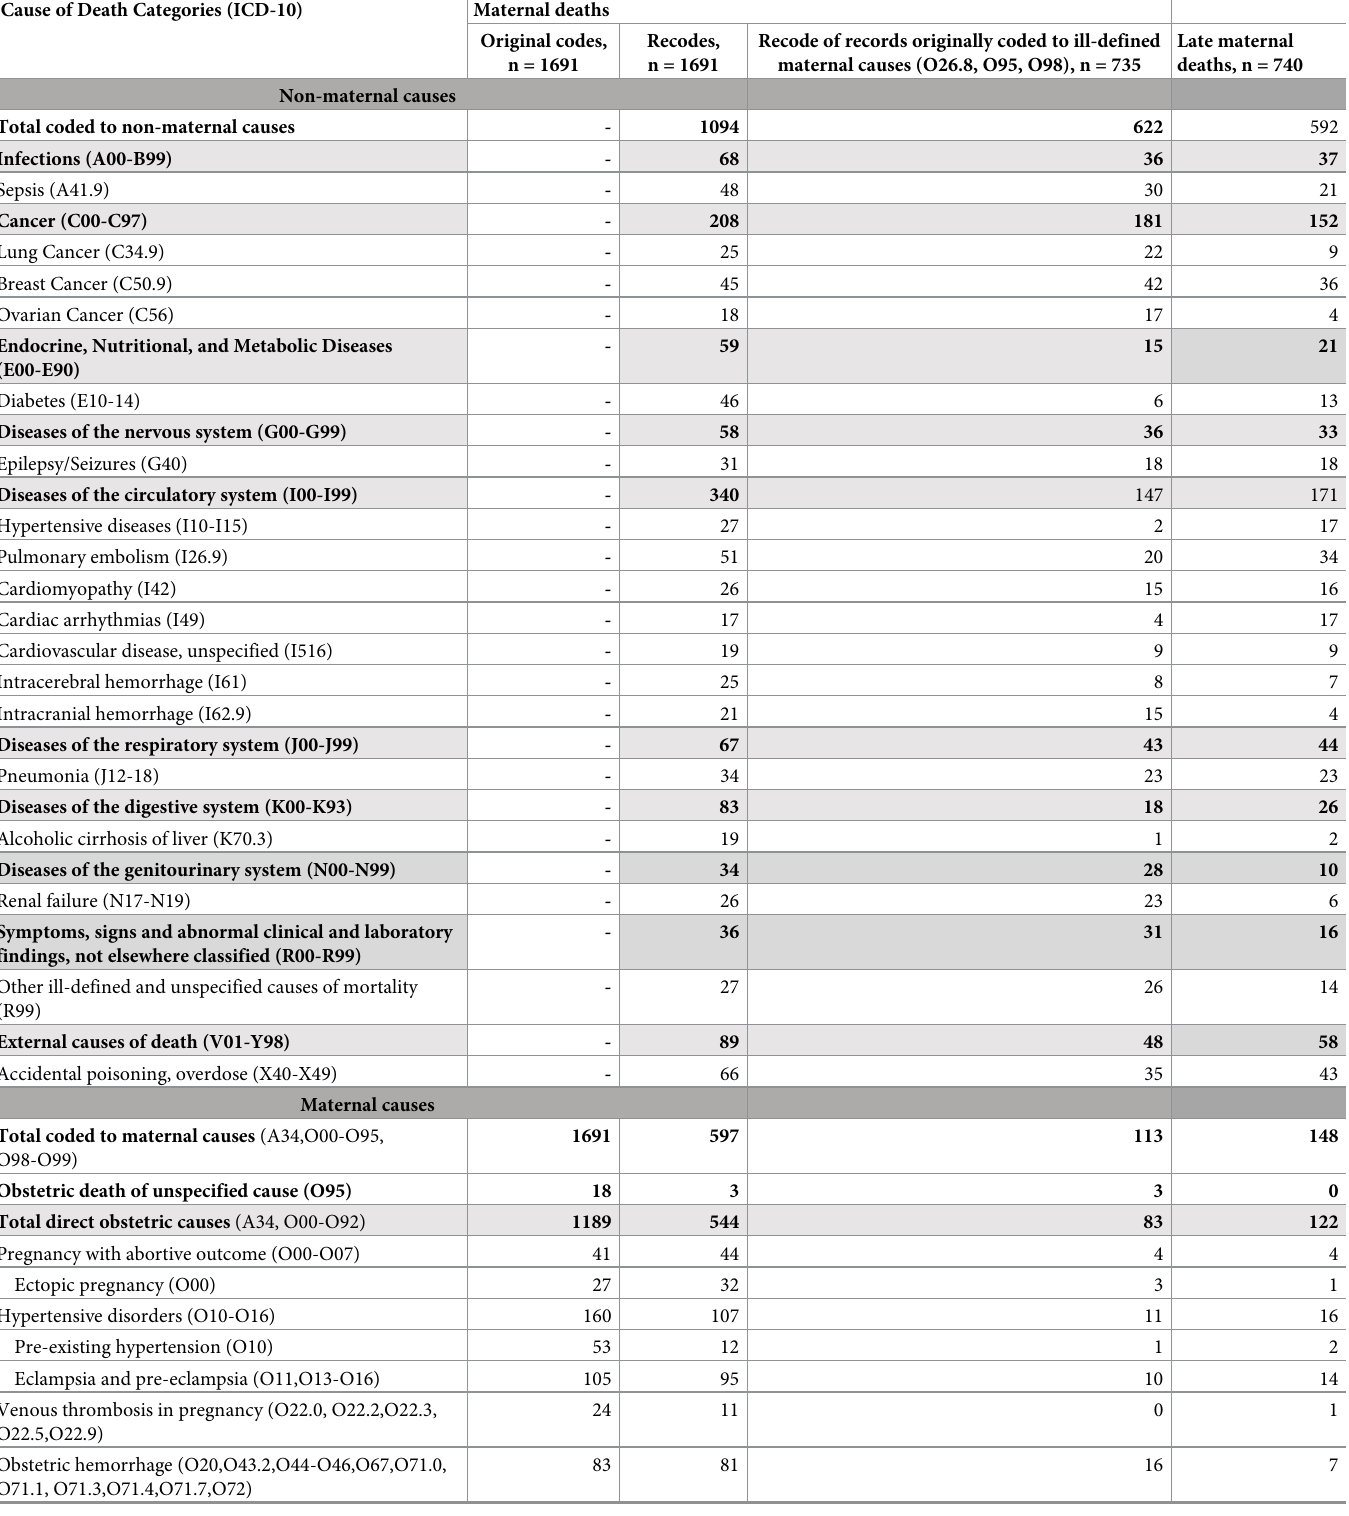
Table 1. Records originally coded as maternal deaths and their recodes, United States, 2016–2017. Cause of Death Categories